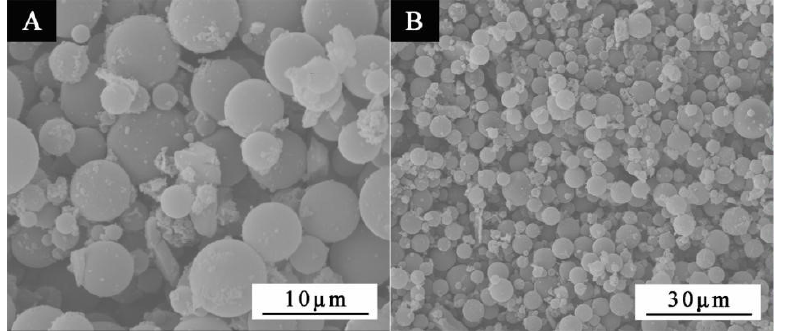
Figure 3. Morphology of the photochromic microcapsules: ( A ) high-magnification SEM image, ( B ) low-magnification SEM image.